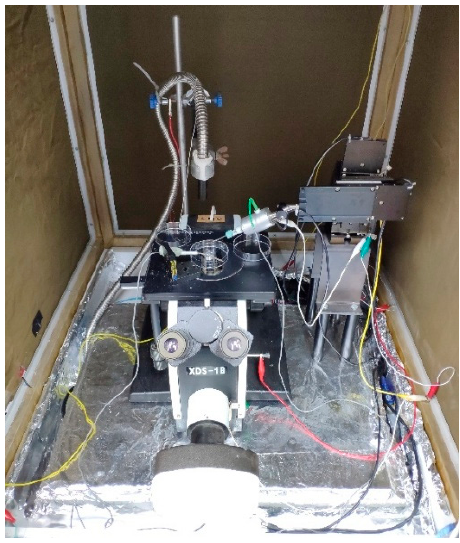
Figure 3. The ion flux measurements system.